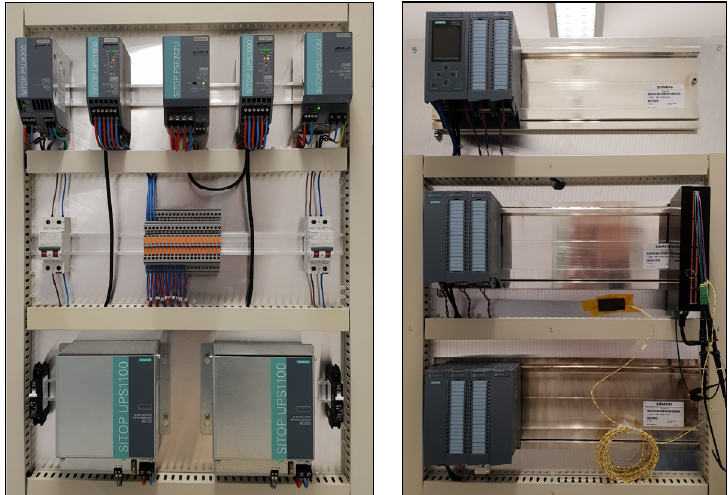
Figure 5. Power distribution and PLC evaluation